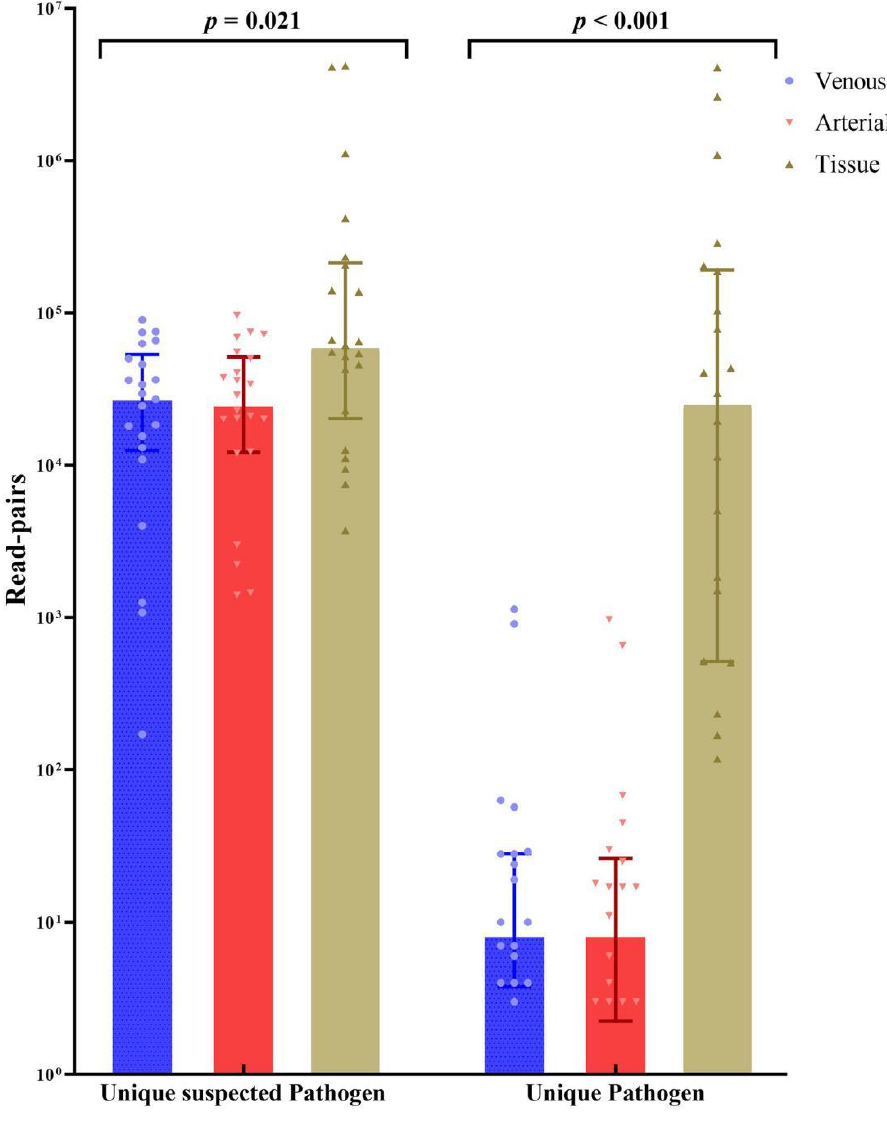
Figure 1. Unique suspected pathogen read-pairs and unique pathogen read-pairs sequenced in the venous blood specimens, arterial blood specimens and resected tissue. A unique suspected pathogen is defined as a unique nonhuman nonredundant sequence aligned with the microbial genome database. (The microbial genome can be downloaded from (The microbial genome of Coxiella burnetii and Bartonella can be downloaded from https://www.ncbi.nlm.nih.gov/sra/PRJNA853129 accessed on 30 June 2022) When the read-pairs of the unique suspected pathogen meet the positive mNGS criteria and the identity of the suspected pathogen is in accordance with clinical manifestations, the unique pathogen is defined. The resected tissue exhibited significantly higher numbers of both unique suspected pathogen read-pairs and unique pathogen read-pairs than the blood specimens by Kruskal – Wallis one-way ANOVA. ( p = 0.021, p < 0.001).